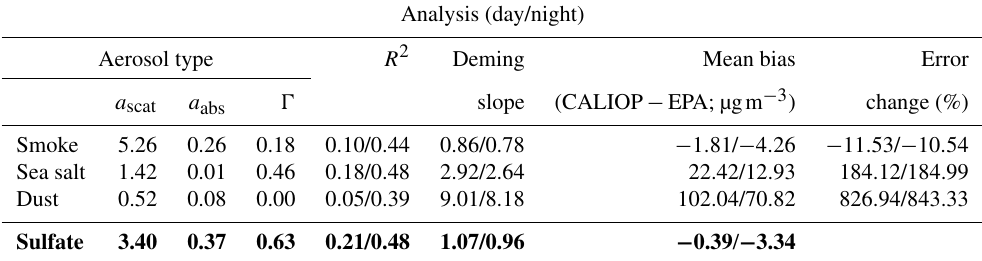
Table 4. Statistical summary of a sensitivity analysis varying the aerosol type assumed in the derivation of PM 2 . 5 , including R 2 , slope from Deming regression, mean bias (CALIOP − EPA) of PM 2 . 5 in micrograms per cubic meter, and percent error change in derived PM 2 . 5 , defined as (( mean new PM 2 . 5 − mean original PM 2 . 5 )/ mean original PM 2 . 5 ) × 100. The row in bold represents the results shown in the remainder of the